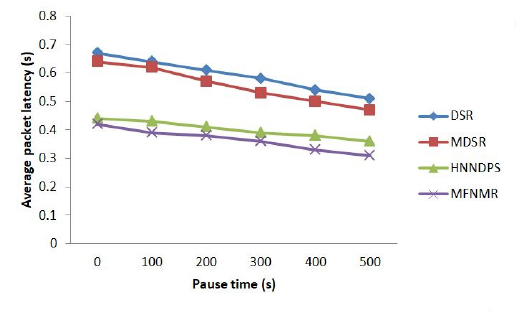
Figure 17. Average Packet Latency Analysis based on Pause Time.